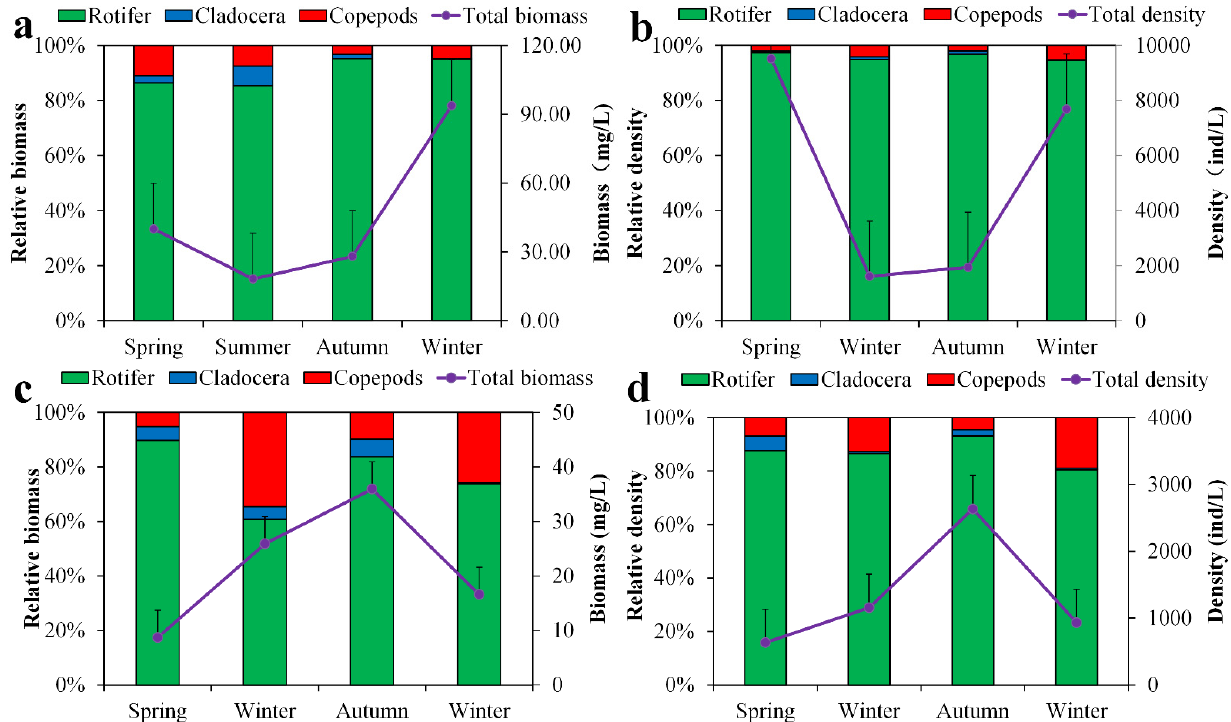
Figure 8. Seasonal distribution of zooplankton biomass and density in Lake Chen Yao ( a , b ) and Lake Feng Sha ( c , d ).